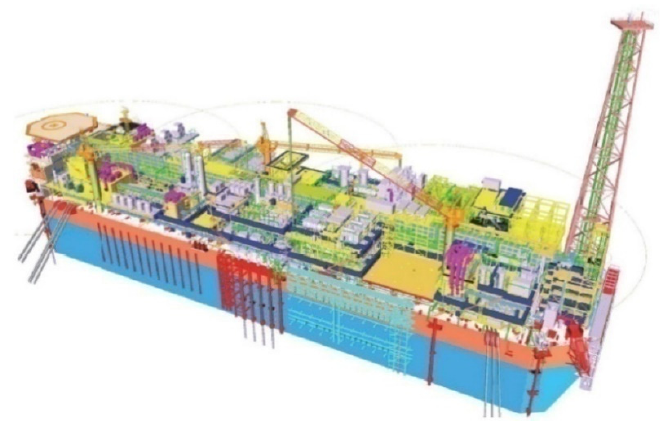
Figure 5. FPSO CAD model.